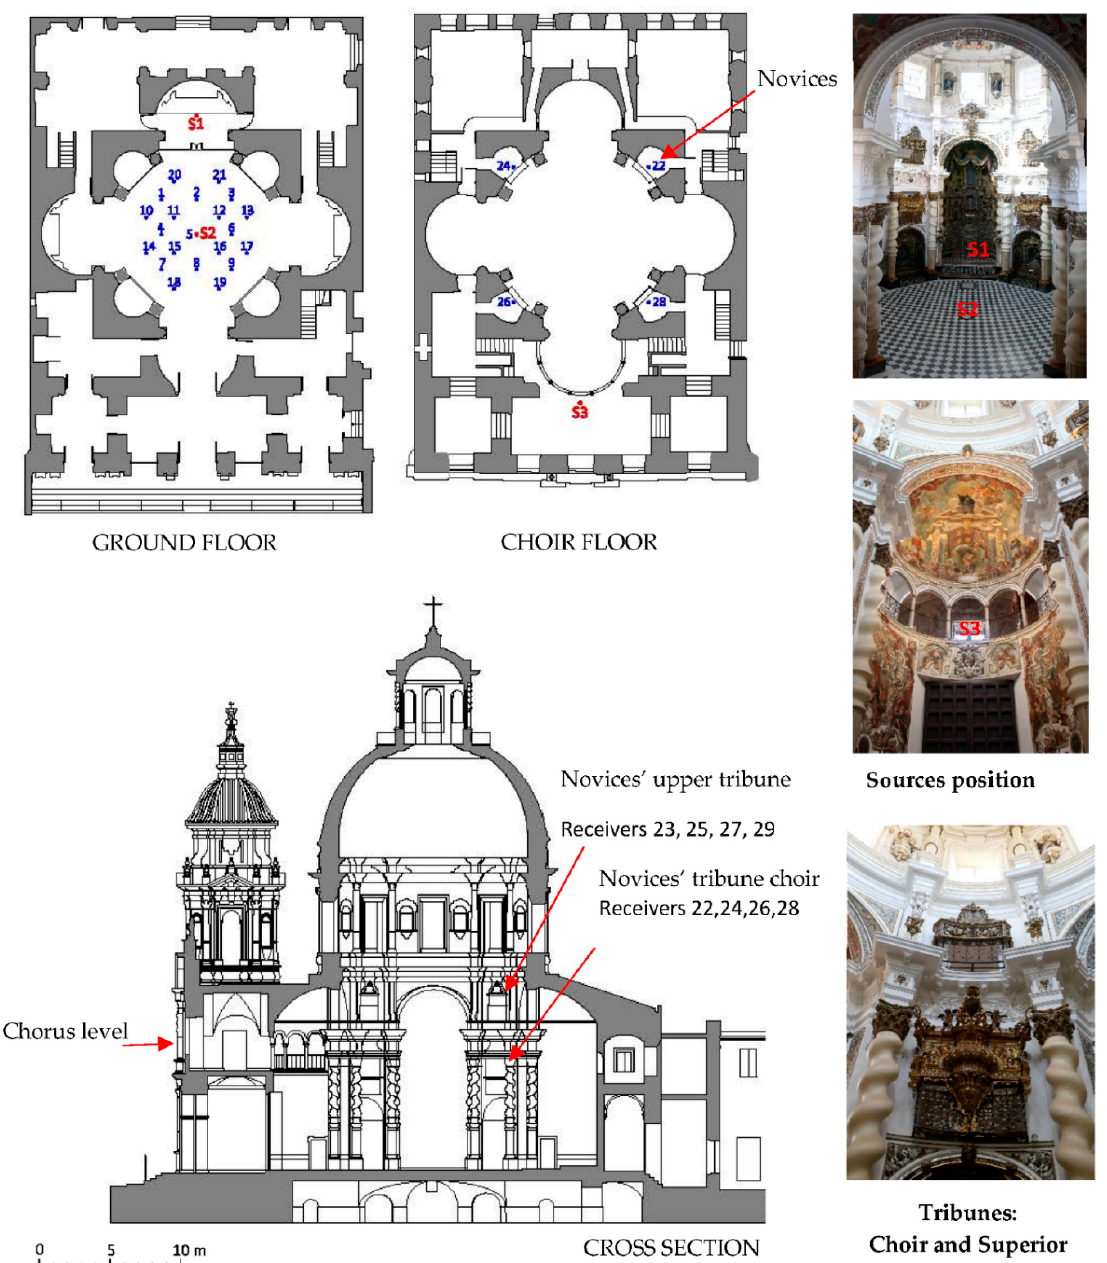
Figure 3. Church of San Luis de los Franceses. Ground floor and choir. Cross section. This space provides enough space on the upper floor for the location of the choir, accessed from the novitiate enclosure on its upper floors. Another aspect to note in the importance of this previous space which provides the interior space, when closed, with better acoustic insulation from the bustle of calle San Luis. The main geometric features of the church are shown in Table